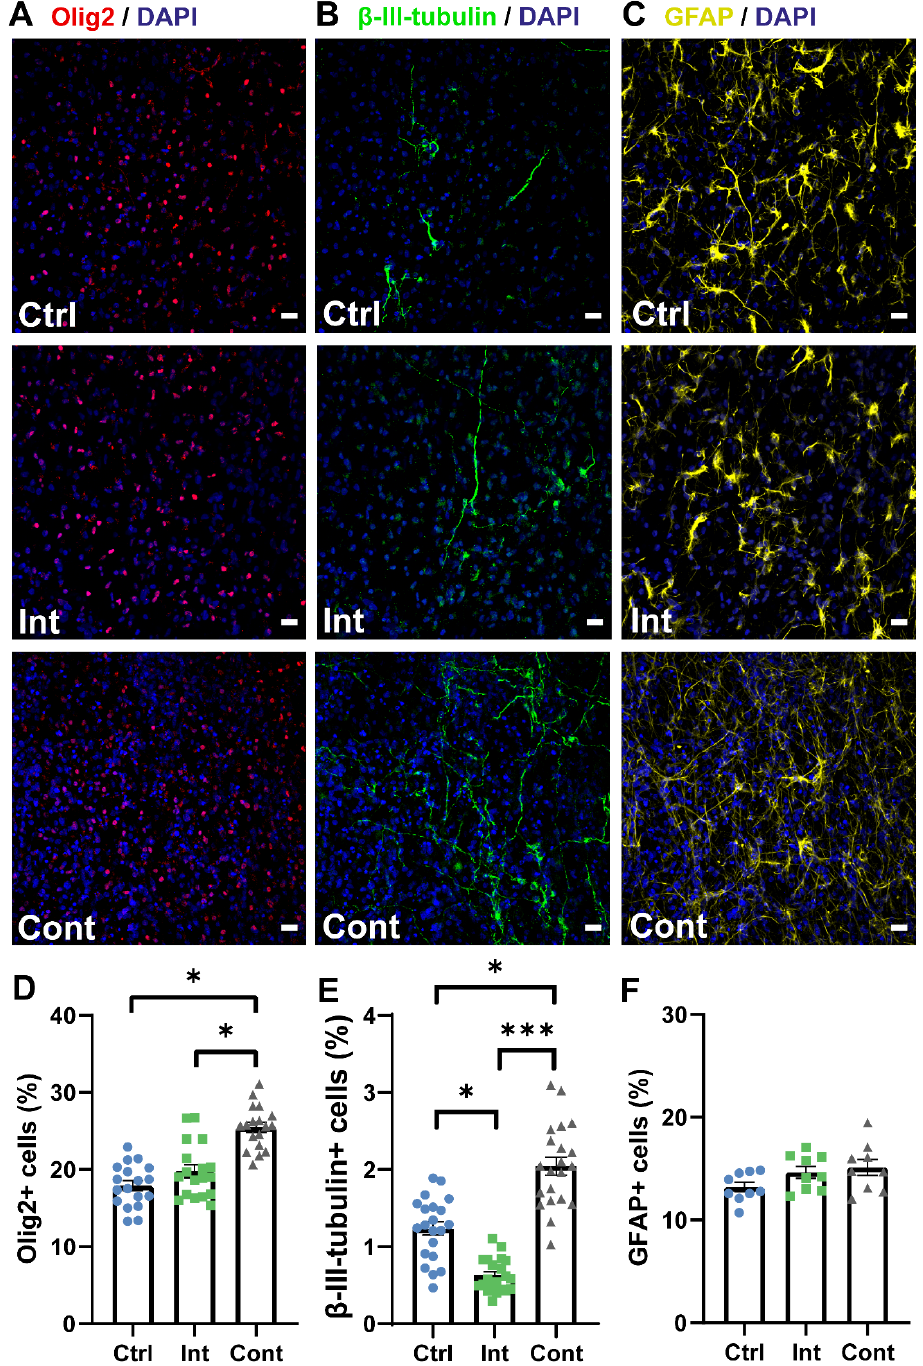
Figure 3. ( A – C ): Representative images of immunocytochemistry staining for DAPI (blue) and Olig2 (red) ( A ), β -III-tubulin (green) ( B ), and GFAP (yellow) ( C ) of the control, intermittent stimu- lation, and continuous stimulation groups. Scale bars: 20 µ m. ( D – F ): Quantification results of the oligodendrocyte percentage ( Olig2 -positive cells/DAPI), neuron percentage ( β -III-tubulin -positive cells/DAPI), and astrocyte percentage ( GFAP -positive cells/DAPI), respectively, for the control (Ctrl), intermittent stimulation (Int), and continuous stimulation (Cont) groups. ( D ) Percentage of Olig2 + cells (Ctrl: 17.92 ± 0.65%; Int: 19.79 ± 0.83%; Cont: 25.47 ± 0.66%). ( E ) Percentage of β -III-tubulin + cells (Ctrl: 1.24 ± 0.09%; Int: 0.63 ± 0.05%; Cont: 2.04 ± 0.12%). ( F ) Percentage of GFAP + cells (Ctrl: 13.21 ± 0.47%; Int: 14.63 ± 0.57%; Cont: 15.11 ± 0.78%). Statistical differences tested by a nested one-way ANOVA. Data are expressed as mean ± SEM. * p < 0.05; *** p <